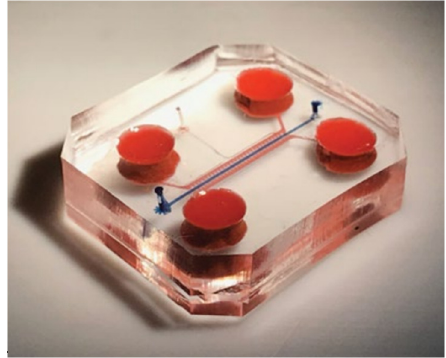
Figure 10. An example of a lab-on-chip system consisting of a lower and upper body part, medium supply channels and a culture channel. Reprinted with permission from [94]. Copyright 2019, Nature Biomedical